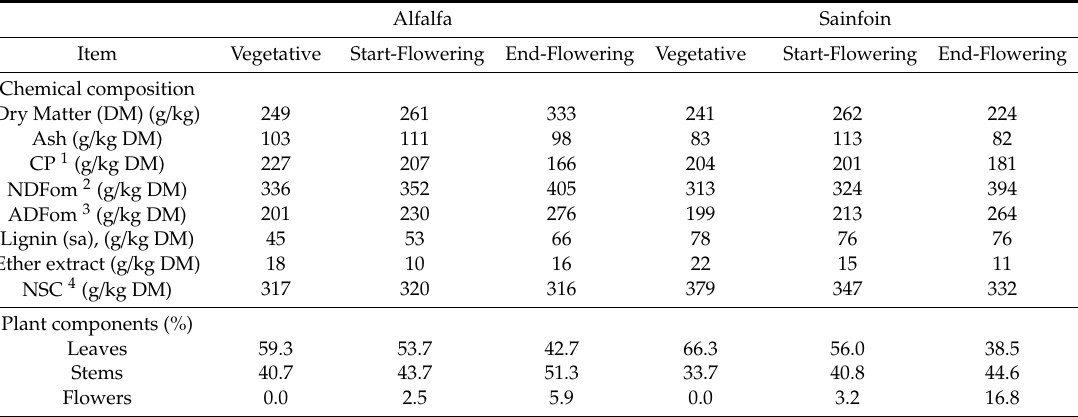
Table 1. Chemical composition and plant components of alfalfa and sainfoin at three stages of maturity. Alfalfa Sainfoin Item Vegetative Start-Flowering End-Flowering Vegetative Start-Flowering